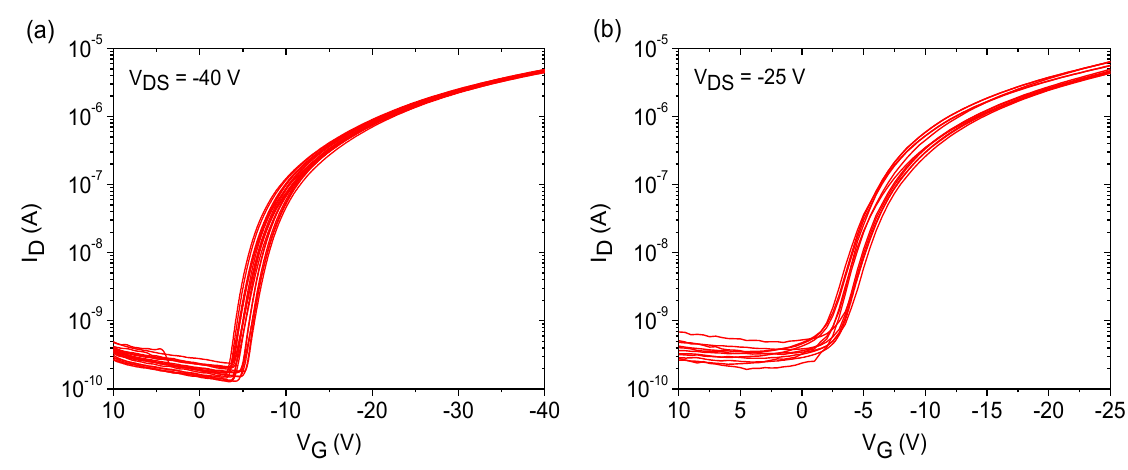
Figure 6. Set of a minimum of 12 transfer curves of OFET devices based on ( a ) PVP and ( b ) SU-8 dielectrics using FS111 measured on three test wafers for each dielectric